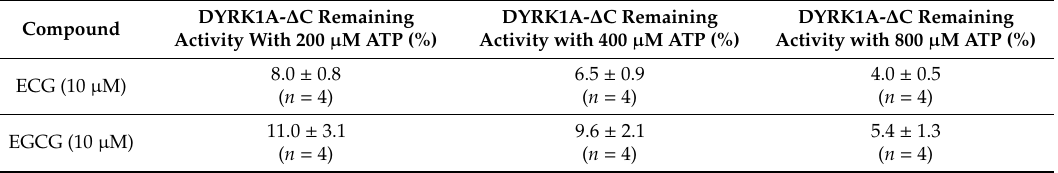
Table 3. Analysis of the inhibition of DYRK1A- ∆ C activity by ECG and EGCG as a function of ATP concentrations.